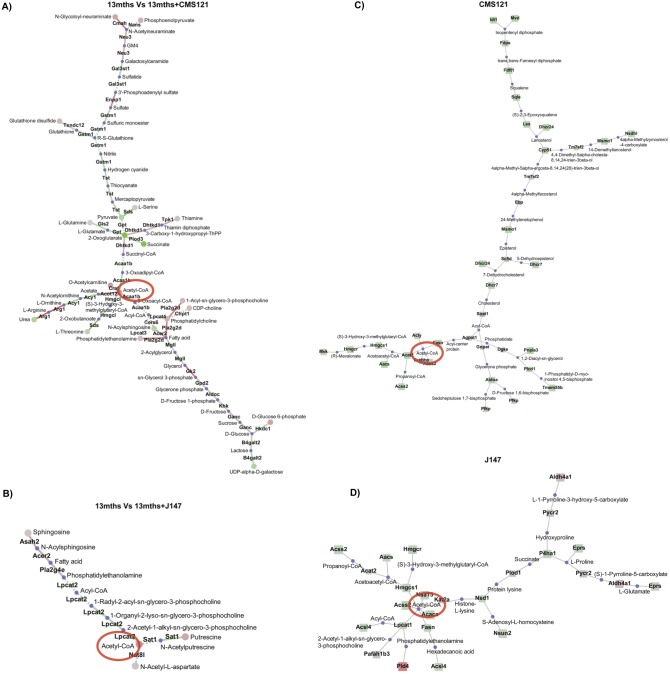
Network analysis.Network analysis was carried out integrating both the transcriptomic and the metabolomic data obtained from the brains of 13 months vs 13 months+CMS121 (A) and 13 months vs 13 months+J147 (B) SAMP8 mice. Nodes represent the metabolites; links represent the genes that encode the corresponding enzymes of the reactions (solid line) or trans-reaction (dashed line). Larger nodes represent lower p-values. Red color indicates up-regulation; green color indicates down-regulation; blue color indicates missing data. Network analysis was also carried out with the whole transcriptomic data obtained from 7 DIV rat primary neurons treated with 1 μM of CMS121 (C) and J147 (D) for 24 hr. Circles represent the metabolites and squares represent the genes that encode the corresponding enzymes of the reactions. Acetyl-CoA is identified in all graphs with a red circle.